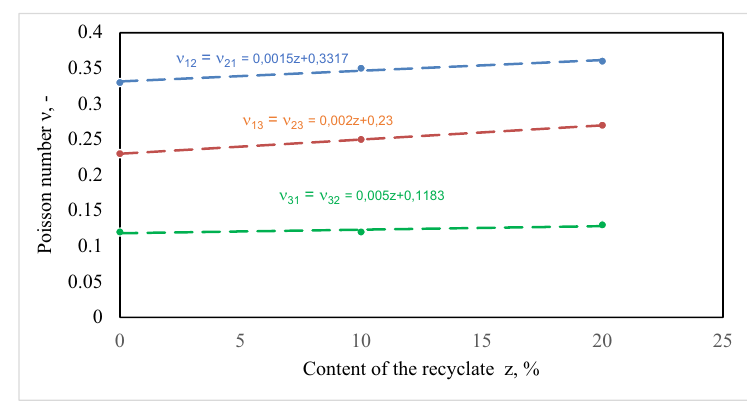
Figure 11: Diagram of dependency between Poisson number and content of the recyclate in